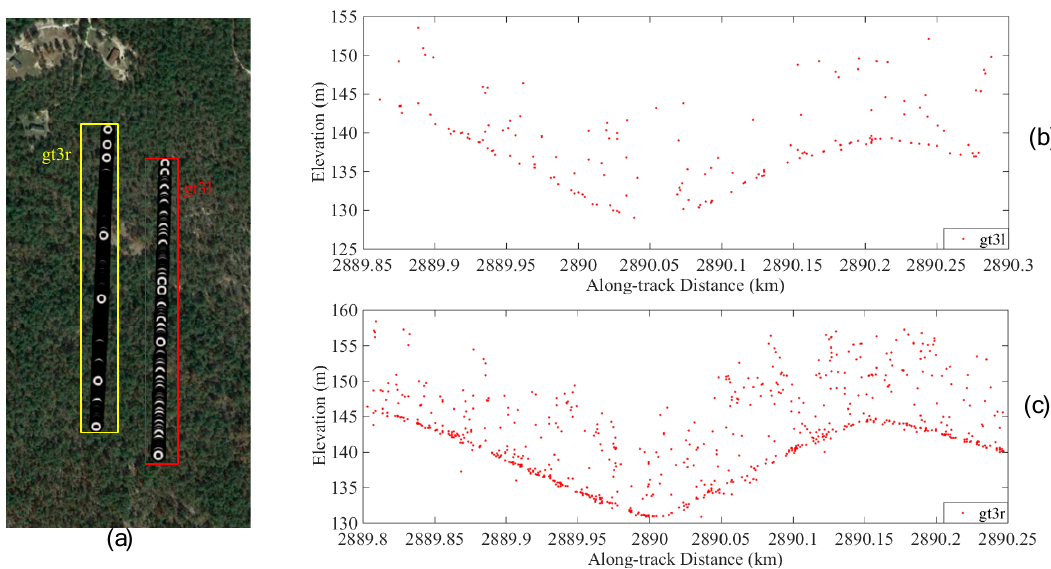
Figure 2. ( a ) The location of gt3r and gt3l data in site 1, City of Aiken, USA. gt3r photons (yellow) and gt3l photons (red) show the location of the Ice, Cloud, and Land Elevation Satellite-2 (ICESat-2) track in Google Earth for context [43]. This illustration only includes signal photons (signal_conf_ph = 4) and is located in City of Aiken, USA. ( b ): Profile of ATL03 photons from the weak beam (gt3l). This data was collected on 26 December 2018 at 05:31. ( c ): Profile of ATL03 photons from the strong beam (gt3r), which has a greater number of signal photons above the surface than in gt3l. Table 2. The statistical indicators of land vegetation elevation (ATL08) product [42].